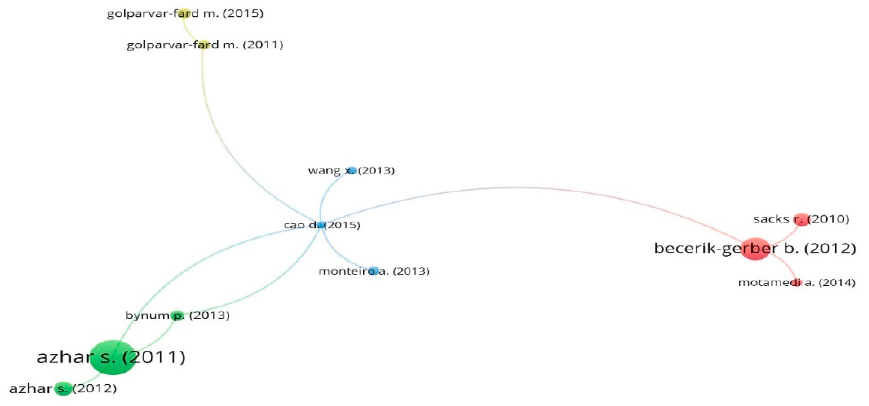
Figure 5. Citation of articles.